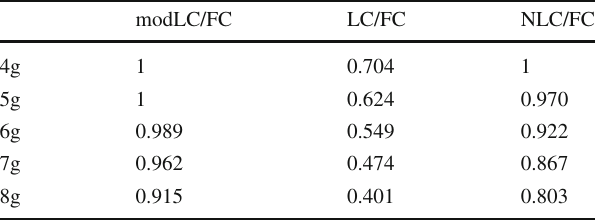
Table 2 The average modLC/FC, LC/FC, and NLC/FC in the all-gluon colour expansion in the fundamental basis